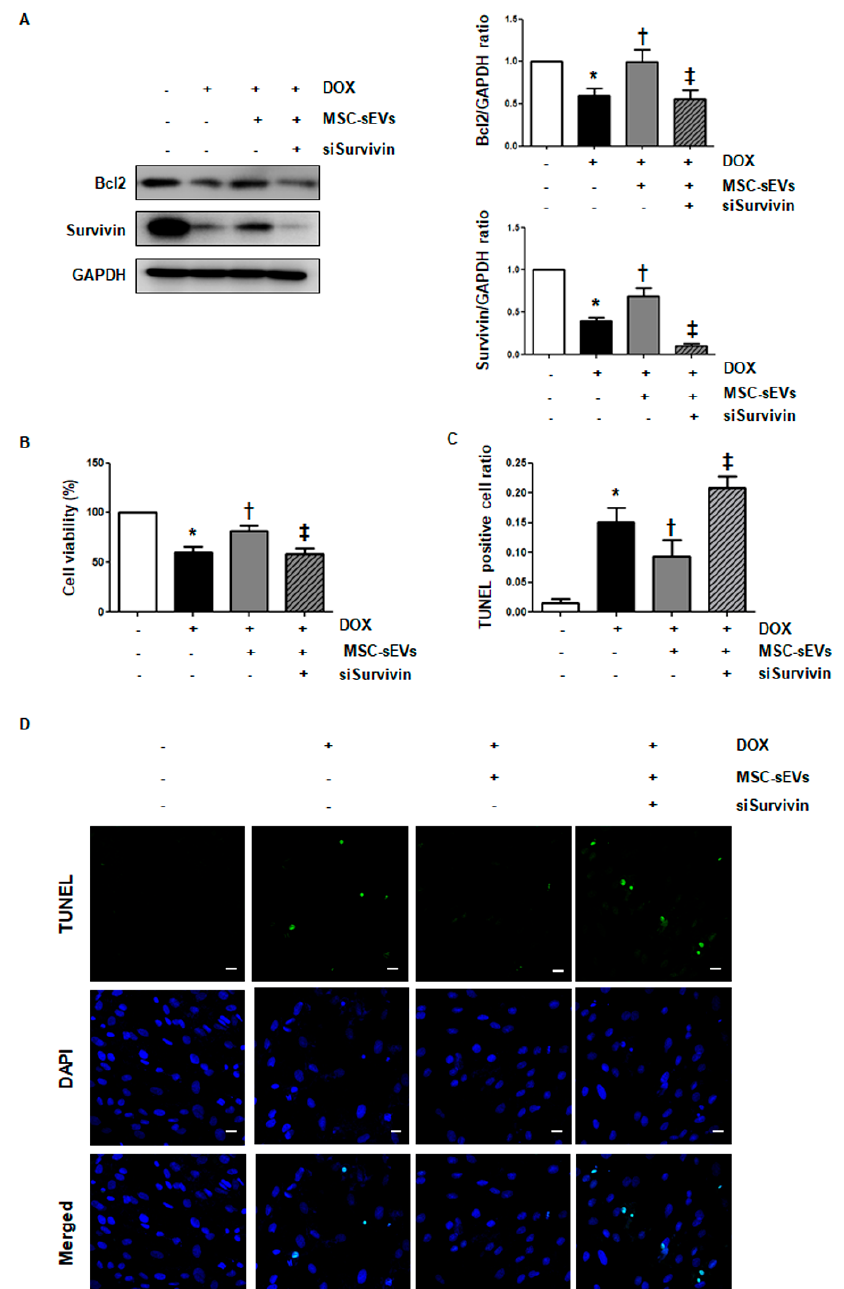
Figure 3. Knockdown of survivin alleviates the cardioprotective effects of MSC-sEVs on DOX − induced cell death. H9c2 cells transfected with siRNA (50 nM) targeting survivin were exposed to MSC-sEVs (3 × 10 9 ) for 24 h and then treated with DOX for 24 h. ( A ) The protein levels of survivin, Bcl − 2, and GAPDH were measured by Western blotting ( n = 5). * Significant difference compared to the control ( p < 0.05). † Significant difference compared to DOX treatment ( p < 0.05) ‡ Significant difference compared to MSC-sEVs + DOX treatment ( p < 0.05). ( B ) Cell viability of each condition was measured using the MTT assay. * Significant difference compared to the control ( p < 0.05). † Significant difference compared to DOX treatment ( p < 0.05). ‡ Significant difference compared to MSC-sEVs + DOX treatment ( p < 0.05). ( C , D ) Cellular apoptosis was measured using the TUNEL assay. Representative fluorescence TUNEL images from at least three independent experiments are shown (magnification, 200 × ; scale bars, 10 µ m). The bar graph shows the TUNEL − positive cell ratio as a cellular apoptotic index. TUNEL − stained cells (green) were counted and normalized to DAPI − stained cells (blue) ( n = 5). * Significant difference compared to the control ( p < 0.05). † Significant difference compared to DOX treatment ( p < 0.05). ‡ Significant difference compared to MSC-sEVs + DOX treatment ( p <